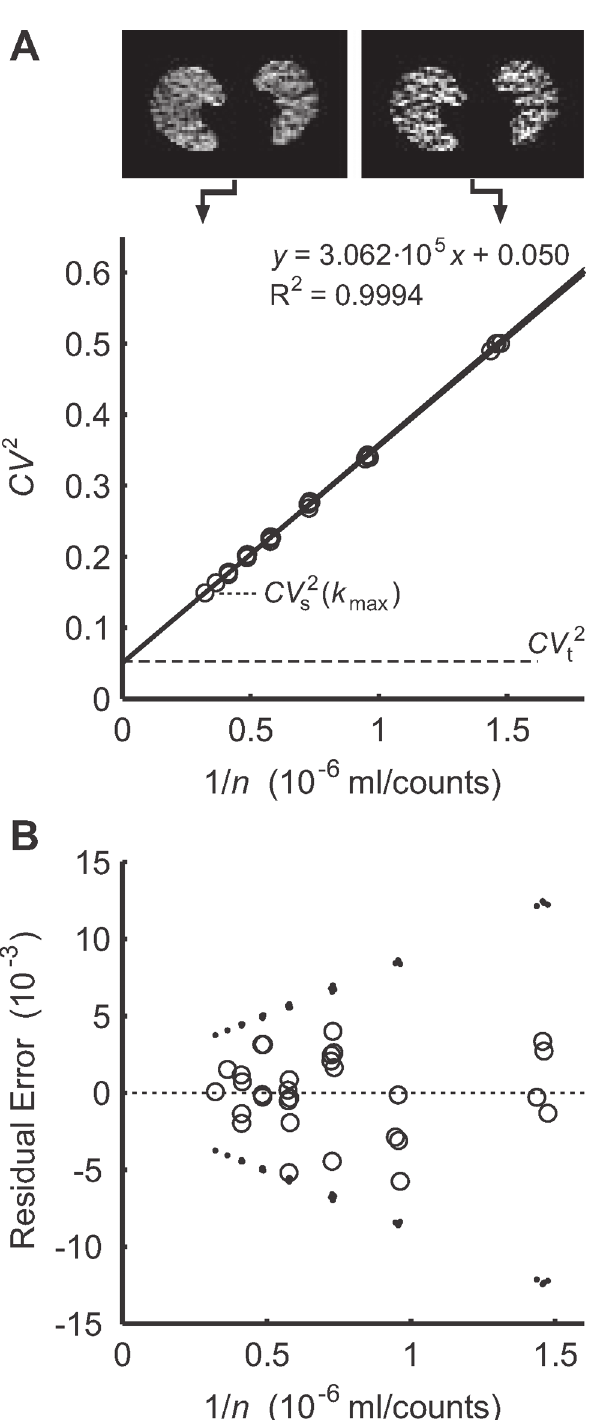
Fig 2. Example of an estimation of noise-free heterogeneity CV t2 of pulmonary blood flow in a subject. A : Linear regression to estimate CV t2 and examples of two selected slices illustrating the difference in the noise levels between a single frame (right) and the merged frame k max with the longest acquisition time (left). Note that the 95% confidence interval is included but visually difficult to distinguish from the regression line. B : Residual errors of the linear regression ( (cid:5) ) were unbiased and symmetrically distributed within the standard error (95% confidence interval) of the variance estimates ( ■ ). This behavior was very similar to the characteristics of the variance in the phantom image (Fig